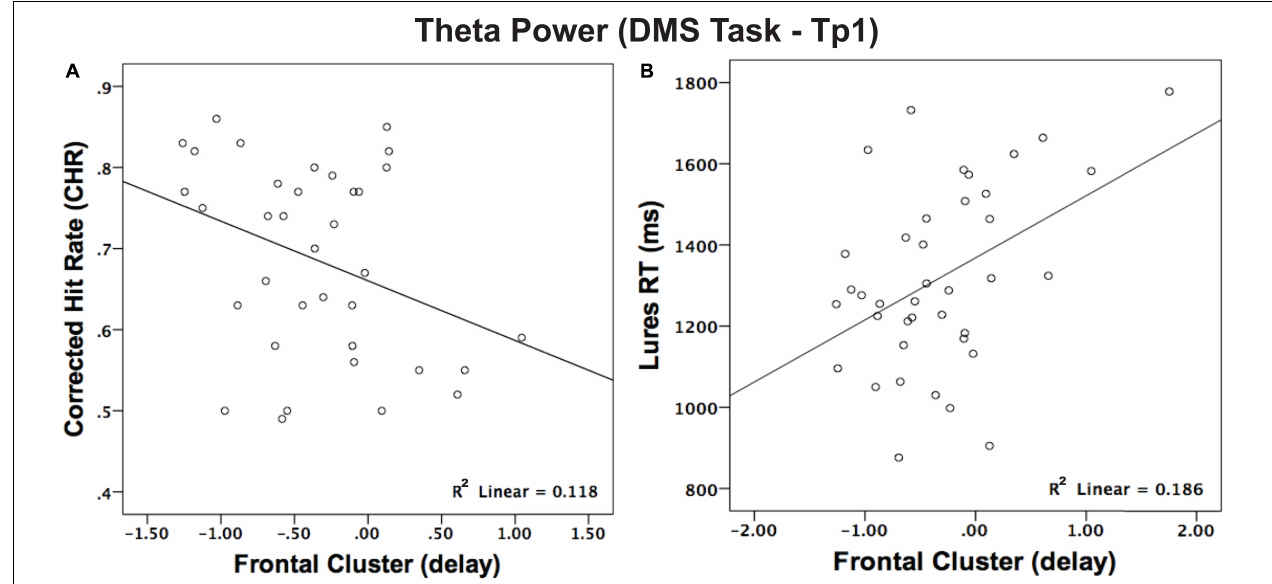
FIGURE 4 | (A) Correlation between theta power in frontal regions and performance (corrected hit rate) during the maintenance phase (delay). Higher scores for corrected hit rates revealed a more prominent event-related desynchronization (ERD) for theta. (B) Correlation between theta power in frontal regions and RT (lure stimuli) during the maintenance phase. Shorter RTs for detecting lure items revealed greater ERD for theta during the maintenance phase (delay). TABLE 4 | Group mean (SD) values for theta and alpha power for frontal and posterior sites pre and post intervention. Exercise Control